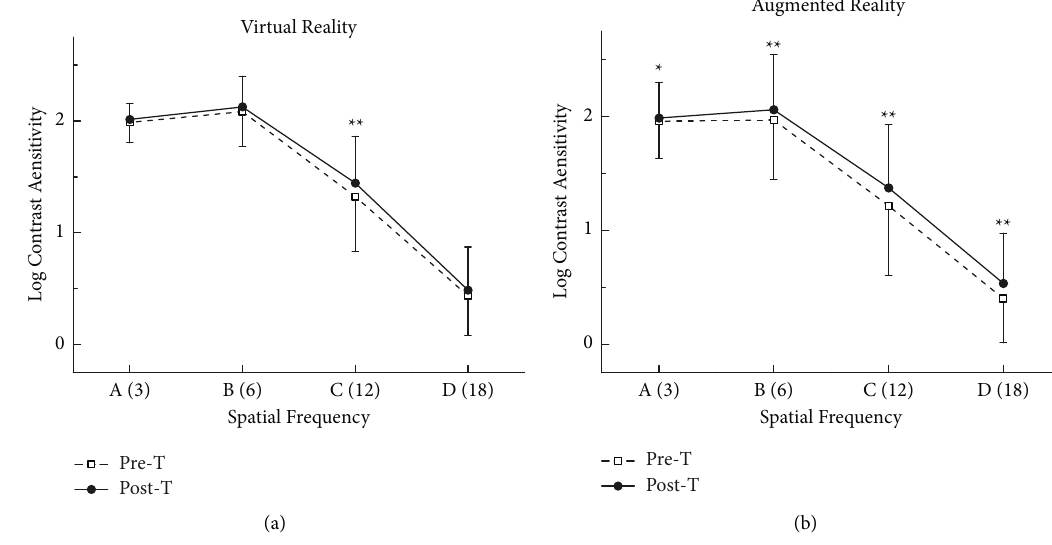
Figure 3: Comparison the CSF between pre- and post-training.